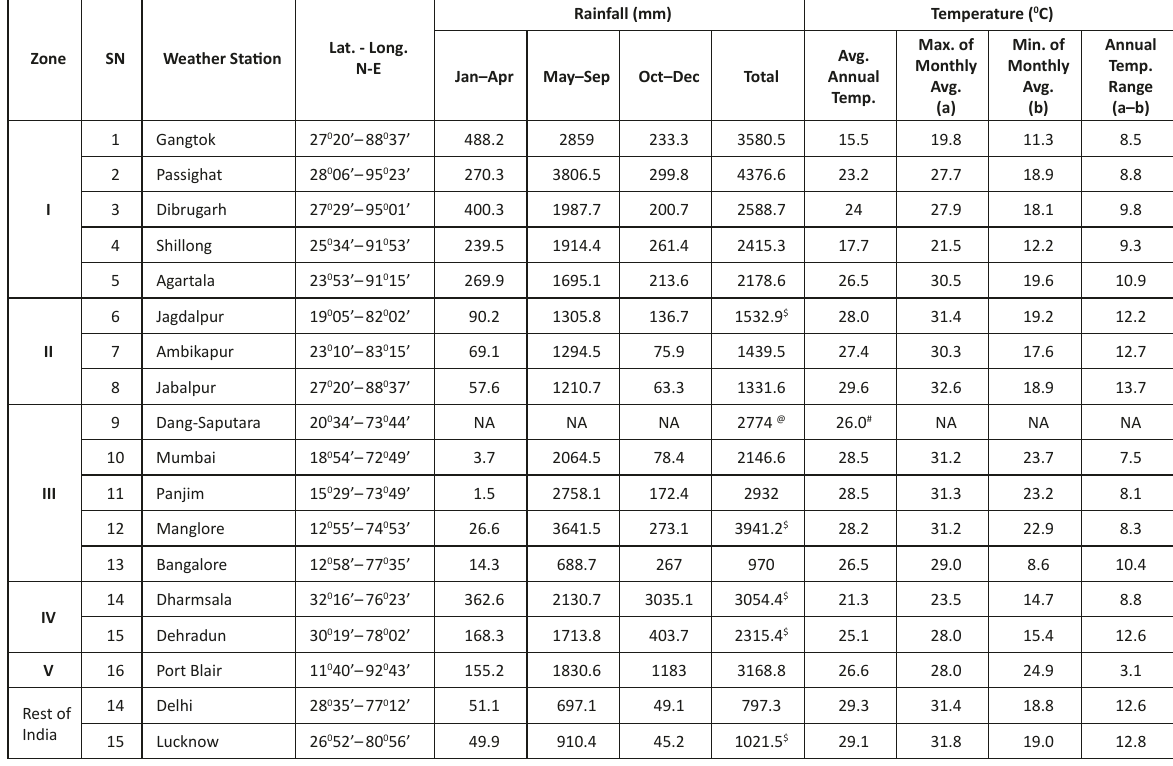
Table 1. Euthalia aconthea butterfly habitat - rainfall and